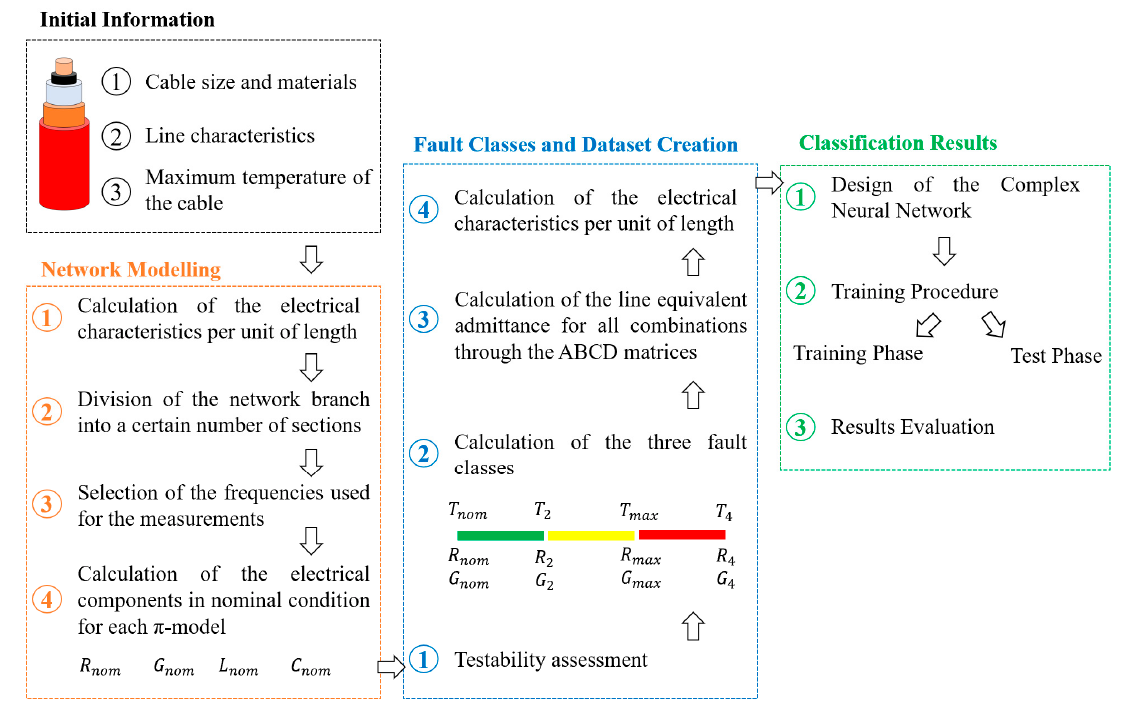
Figure 8. Block diagram of the proposed method. Table 4. Electrical characteristics of the cable in nominal